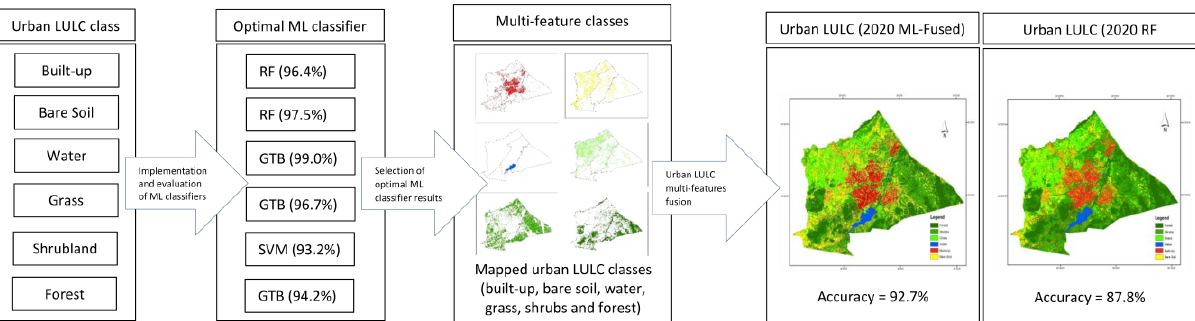
Figure 14 . Multi-feature classification and fusion